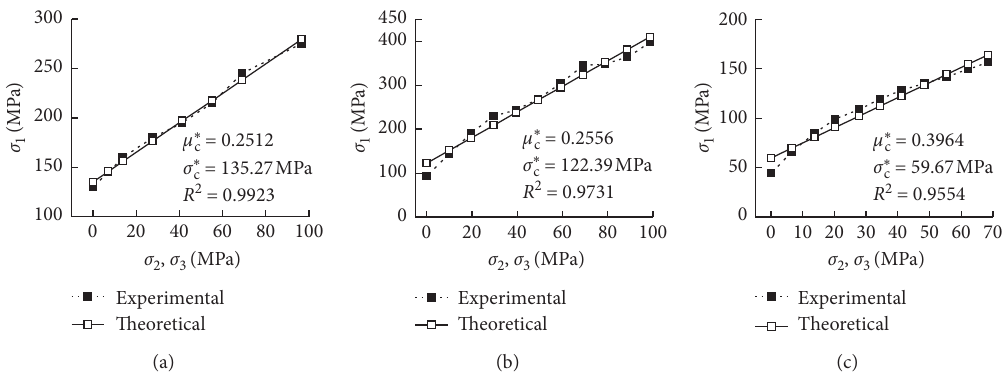
Figure 7: Conventional triaxial test data and theoretical results of (a) Tennessee marble [29, 30], (b) Daye marble [6, 30], and (c) Indiana limestone [30, 31].